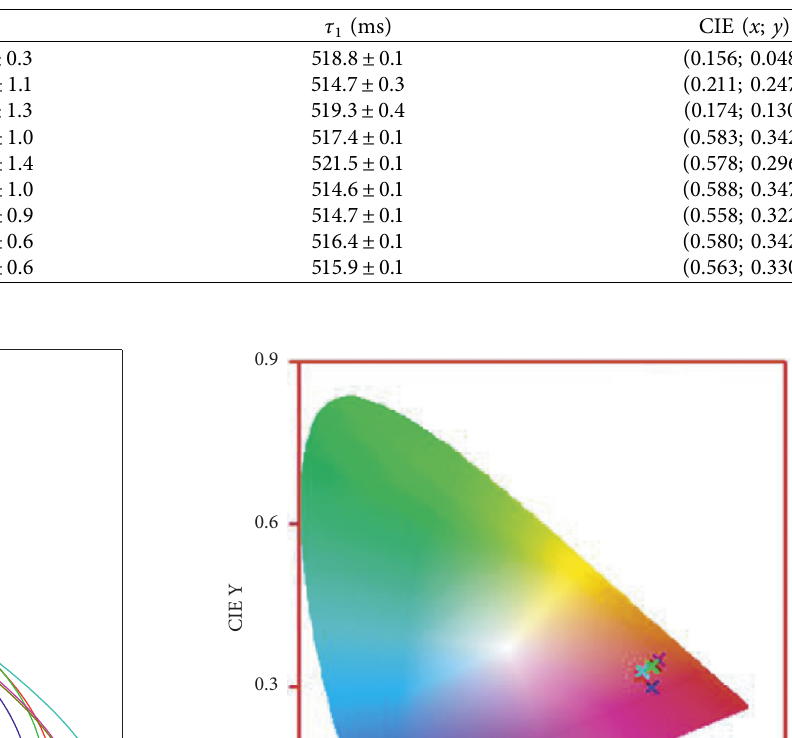
3+ (0 ≤ x ≤ 5.5). 2 O 4 , CaAl 4 O 7 , and BC: x % Eu